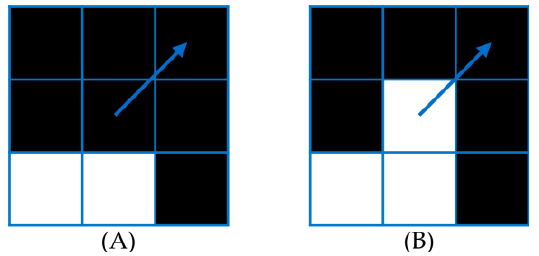
Figure 6. Density configurations that are misinterpreted by the Sobel/Prewitt kernels.. Both subfig- ures (A) and (B) show that the density gradient approximation via matrix convolution is 45° rather than the naturally perceived overhanging angle of 90°.